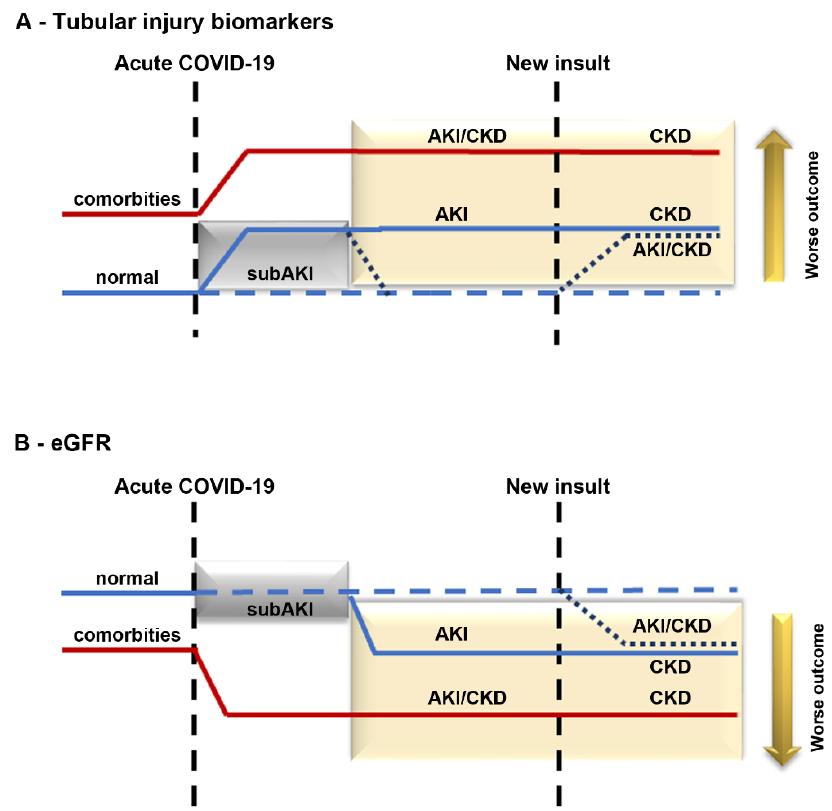
Figure 2. Proposed model for progression of kidney disease in patients with COVID-19. Kidney injury in patients with COVID-19 without (blue line) or with (red line) comorbidities. In an acute phase, patients with COVID-19 develop subAKI (gray box) characterized by an increase in tubular injury biomarkers ( A ) without changes in eGFR ( B ). If the repair mechanism works, the levels of tubular injury biomarkers return to normal (dotted blue line). On the other hand, subAKI can progress to AKI if the repair mechanism is insufficient (solid blue line inside the yellow box). In the case of patients with already established comorbidities, such as hypertension and diabetes (red solid line), an increase in the level of tubular injury biomarkers and a decrease in eGFR can be observed. If these patients are infected with COVID-19, their renal injury is aggravated, leading to faster progression of kidney injury. Patients with COVID-19 who develop any kind of renal injury, including subAKI (new insult), are at higher risk of developing kidney disease post-COVID-19.